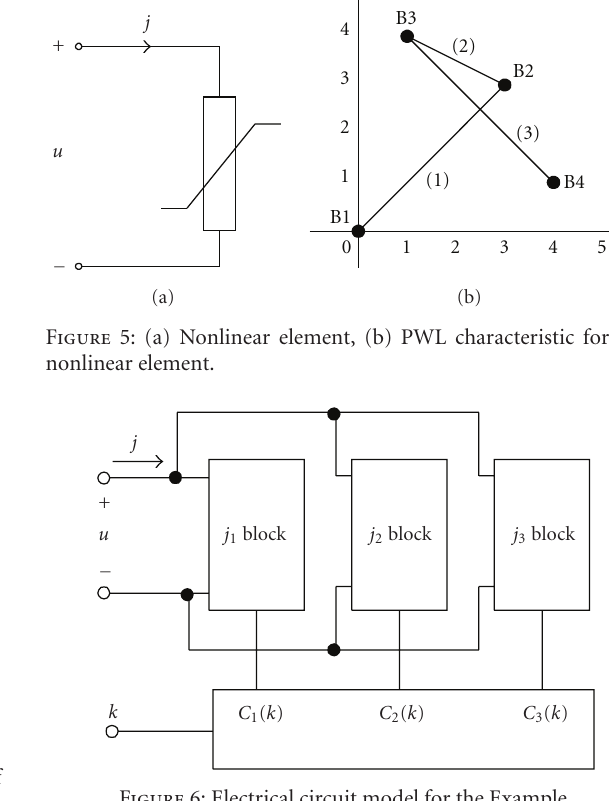
Figure 6: Electrical circuit model for the Example. graphic coordinates are designated as B1, B2, B3, and B4, and summarized in Table